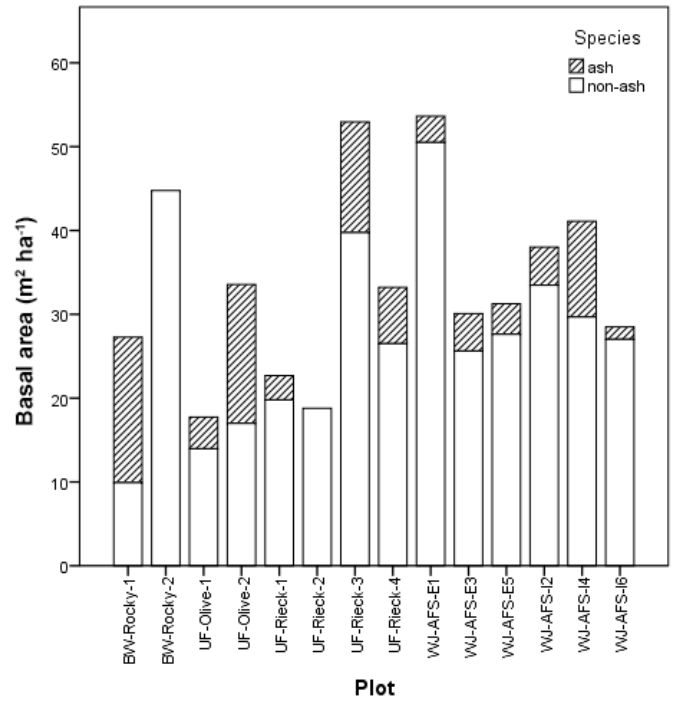
Figure 2. Cumulative basal area of trees by Fraxinus spp. (hatched) and non- Fraxinus (open) across plots at year of EAB detection at Baldwin-Wallace University (BW, 2015), University of Findlay (UF, 2010), and Washington & Jefferson College (WJ, 2012) sites.